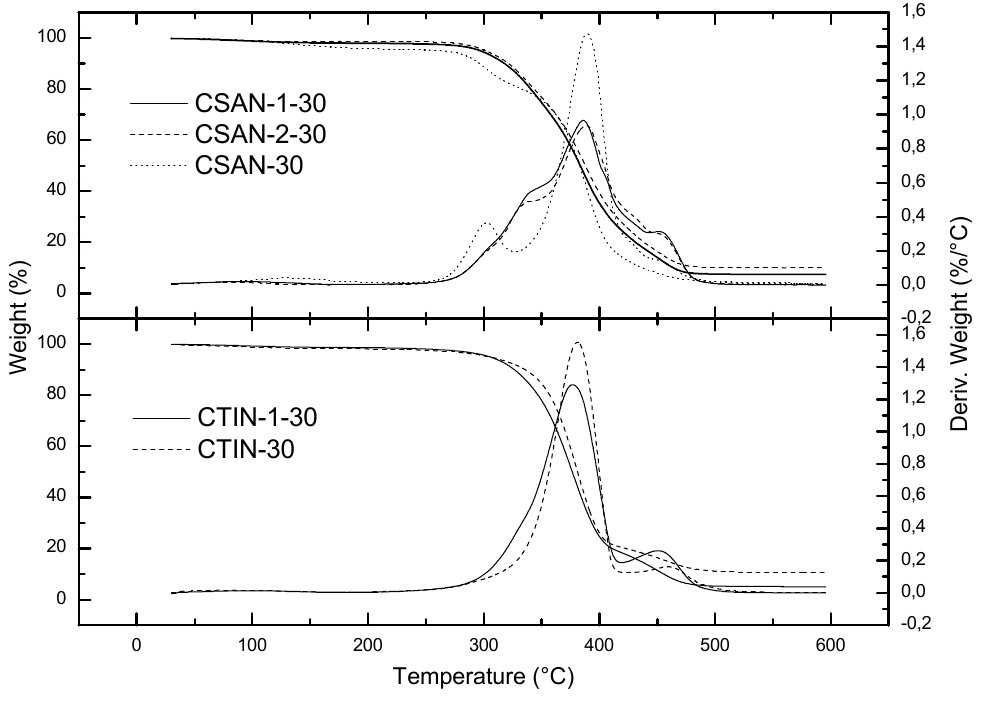
Figure 6. Thermal degradation curves, under inert atmosphere, for –NCO–functionalized and non-functionalized chitosan and chitin gel-like dispersions in castor oil.